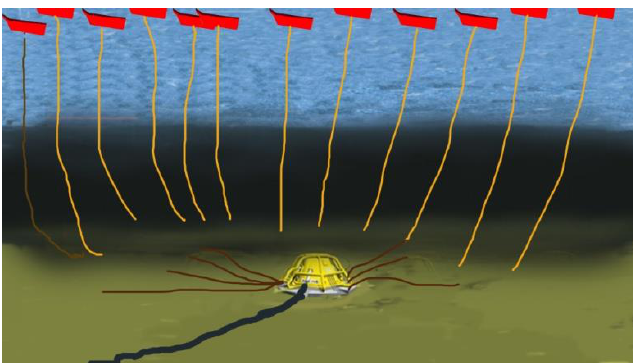
Figure 6. Concept diagram of a wave energy conversion plant in the ocean using linear rotating generators for wave energy conversion.